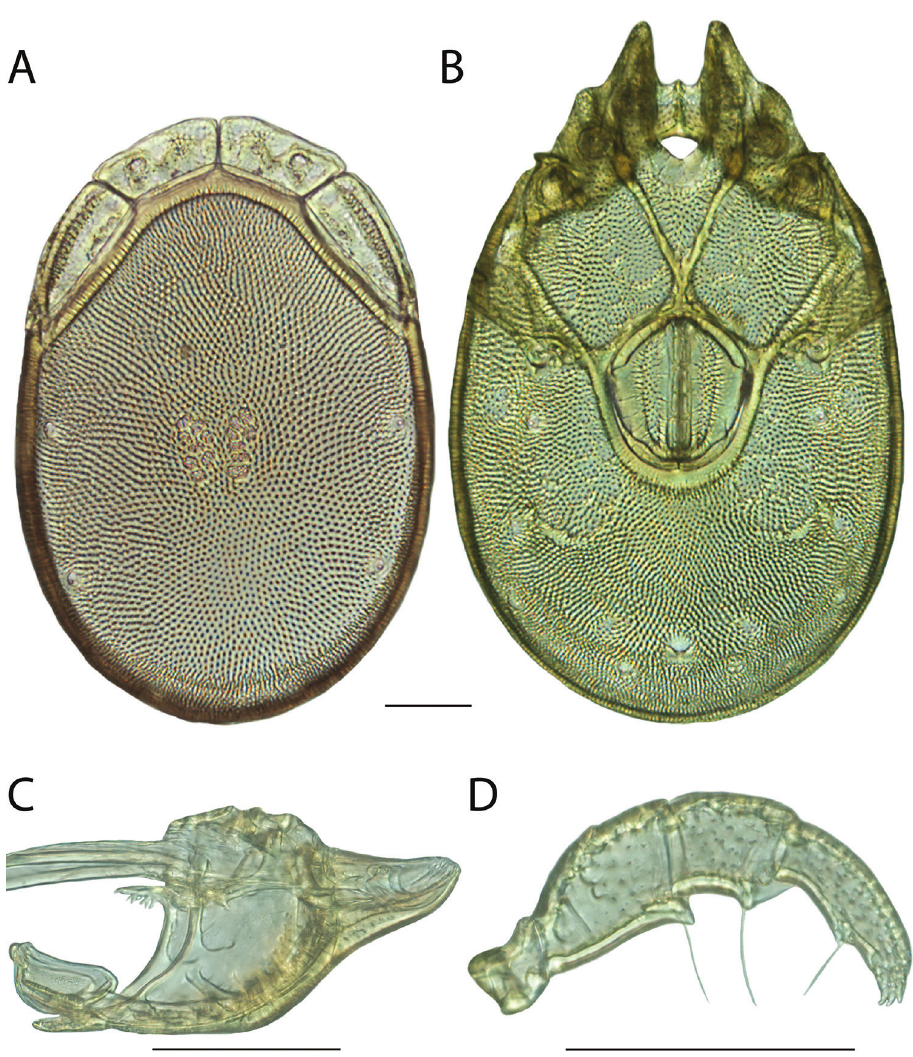
Figure 209. Torrenticola rala female: A dorsal plates B venter (legs removed) C subcapitulum D pedi- palp (setae not accurately depicted). Scale = 100